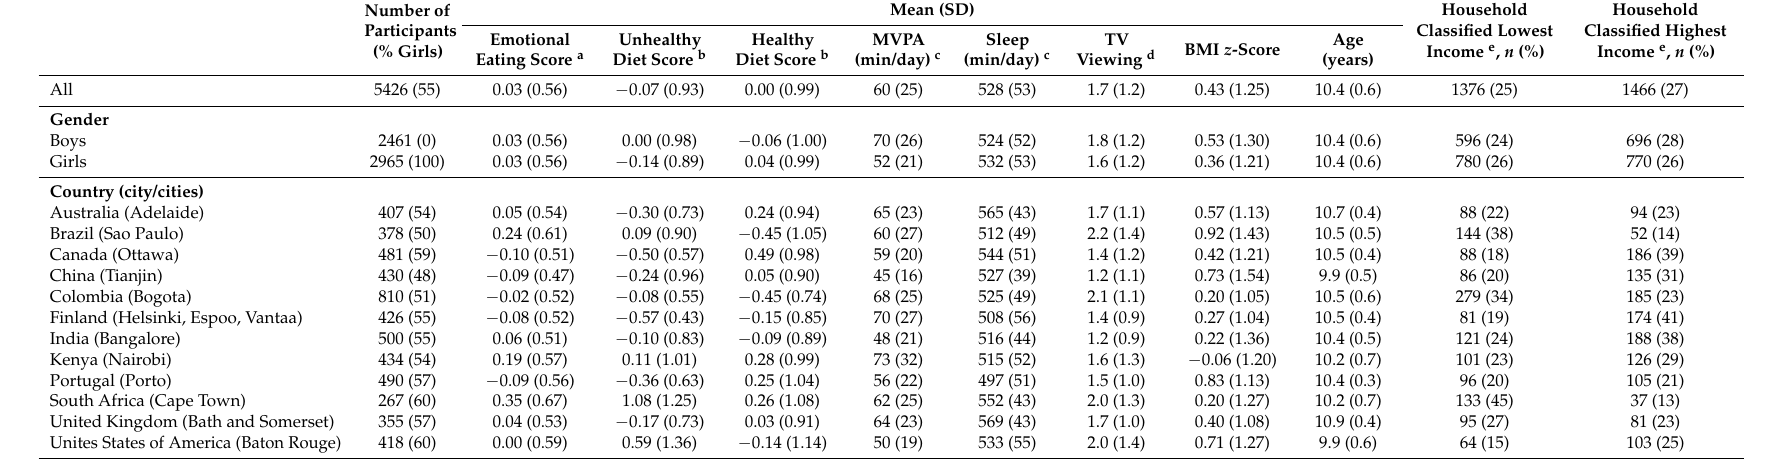
Table 2. Descriptive results of the analytical sample by gender and country